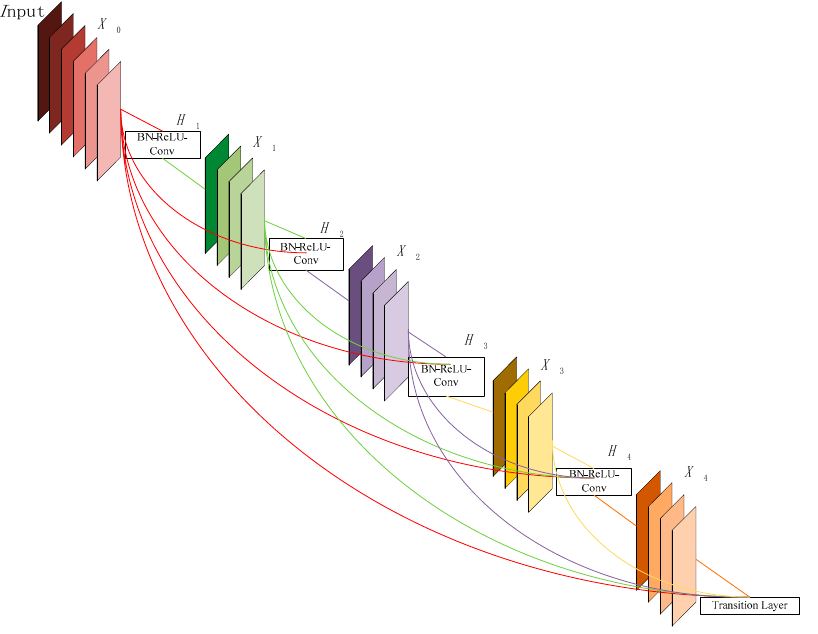
Figure 6. The basic structure of the dense block .